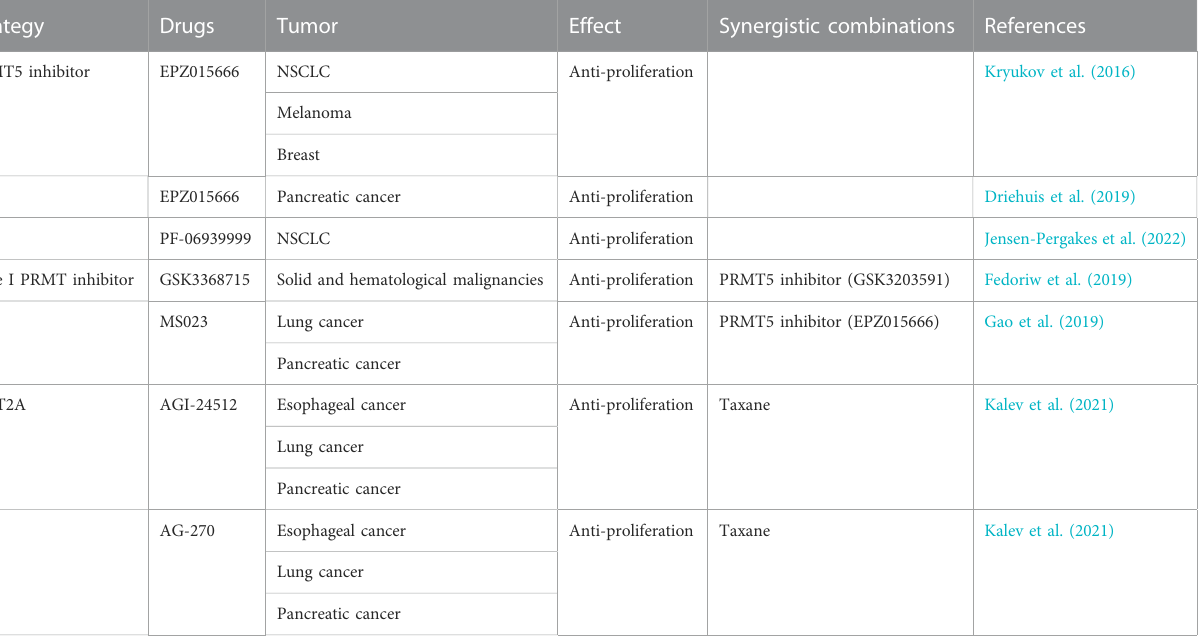
TABLE 1 Current therapeutic strategies for treating MTAP-de fi cient tumors.